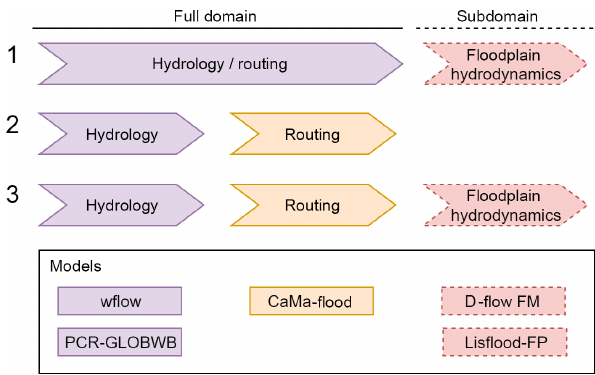
Figure 1. Supported and tested coupling configuration and sup- ported models of GLOFRIM 2.0. We distinguish between hydro- logic (purple), routing (yellow), and floodplain (2-D) hydrodynamic models